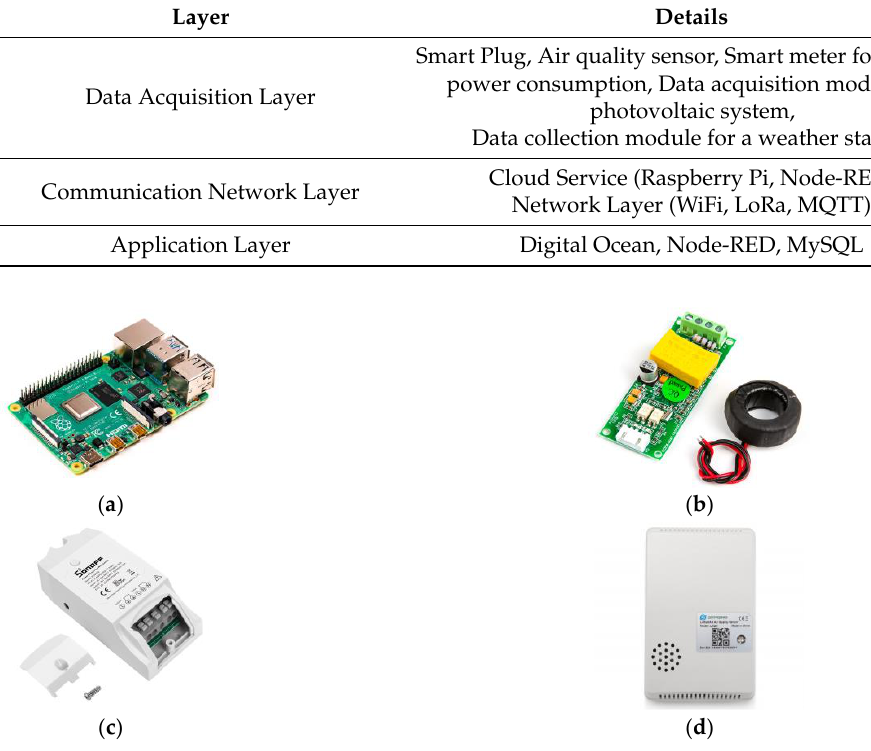
Figure 5. Selected devices for data acquisition layer: ( a ) Raspberry Pi 4B; ( b ) PZEM-004t-100 A; ( c ) Sonoff Pow R2; and ( d ) Air quality LAQ4.